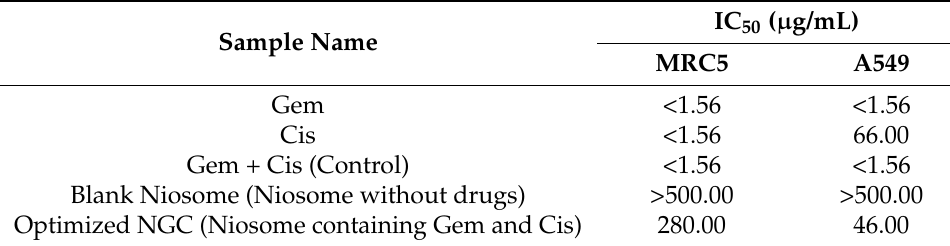
Table 8. IC 50 values of the samples after 72 h